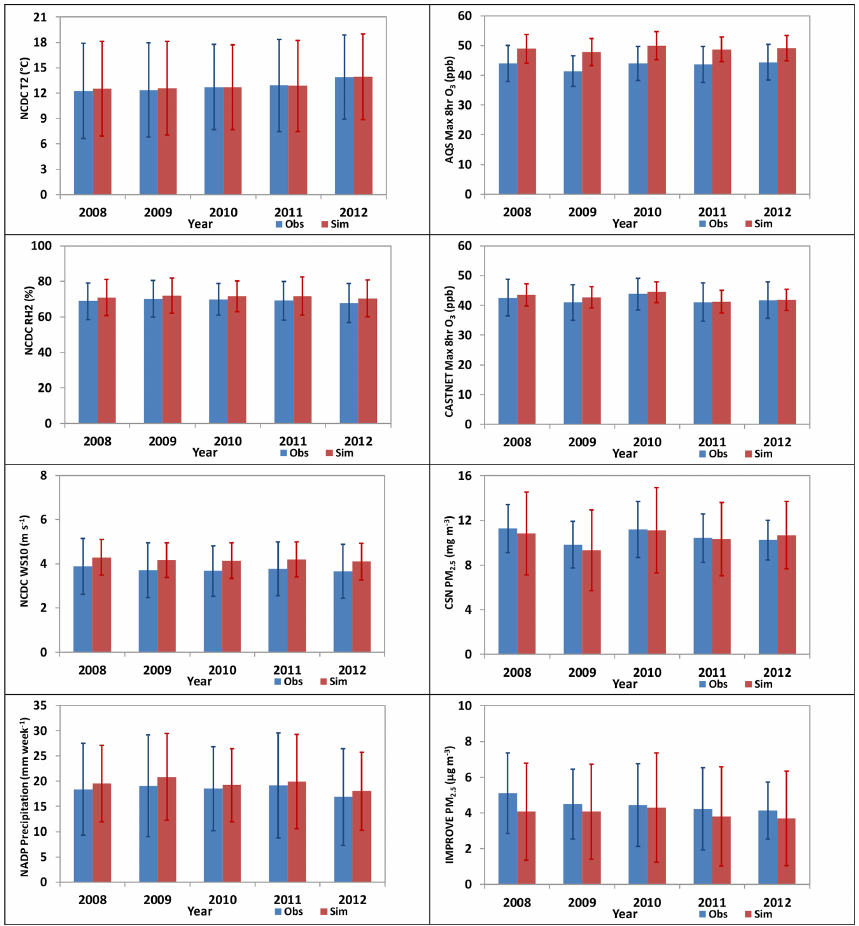
Figure 3. Bar charts for annual average observations and simulations (standard deviations are displayed as the error bars) from two-way WRF-CMAQ for major meteorological variables (left column) and chemical species (right column) in